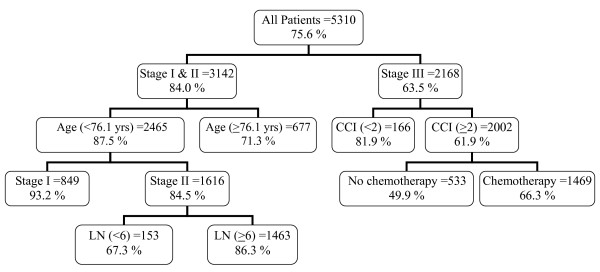
Decision tree constructed by recursive partitioning analysis (training sample).